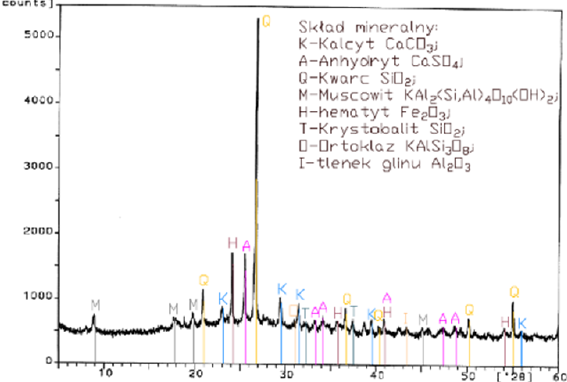
Figure 3. XRD pattern of fluidized bed combustion fly ash from combustion of hard coal (FBC II).